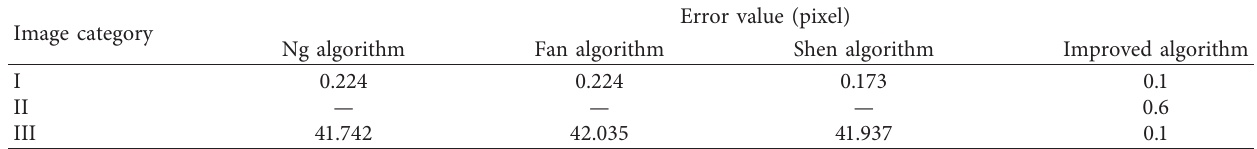
Table 2: Position deviation value of each threshold segmentation